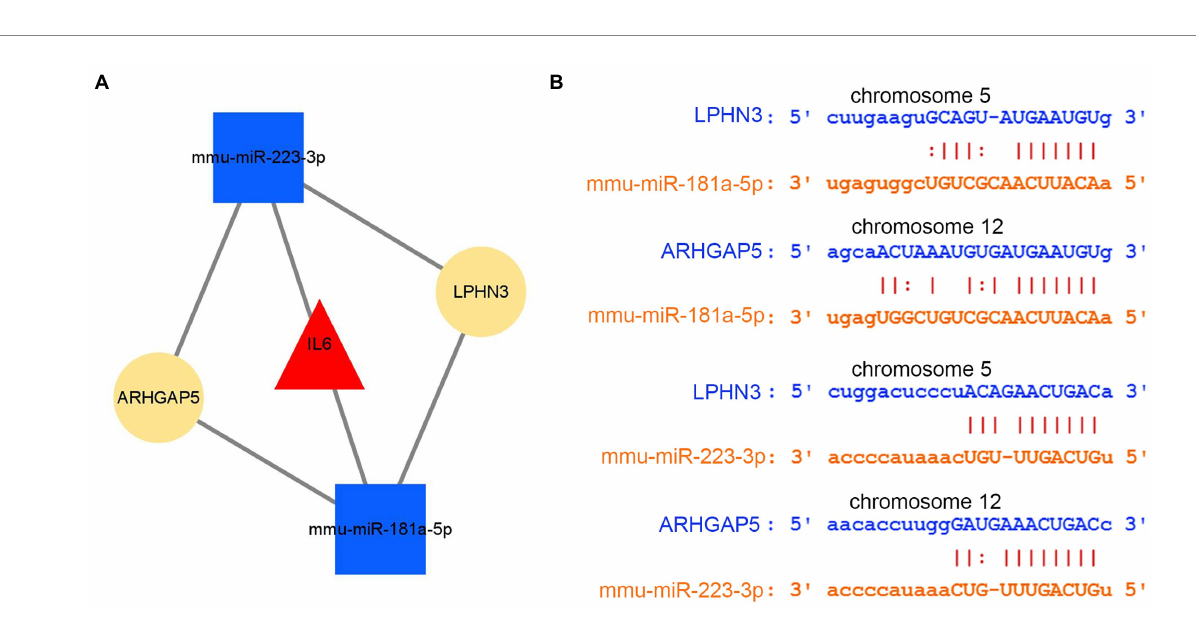
associated with pathogenesis in NeP. Similar to KEGG, the results of